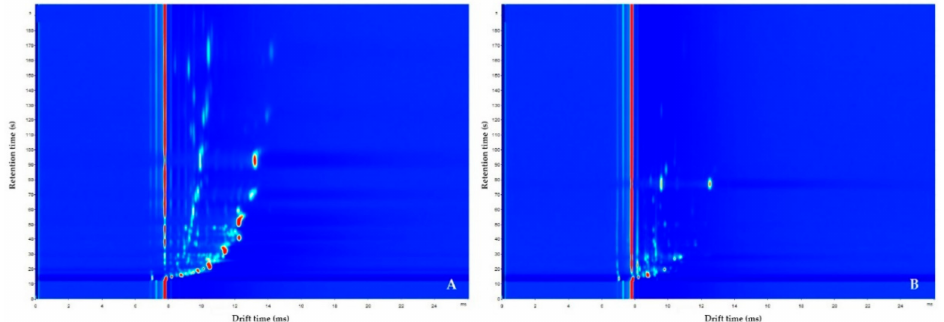
Figure 3. Examples of GC–IMS output. Here, the GC-IMS of fecal ( A ) and urinary ( B ) VOC profiles of one IBD patient are displayed. On the y-axis, the retention time indicates the separation time of the analyte by means of gas chromatography. The color represents the VOC concentration using color spectrum from blue to red, indicating low concentration to high concentration,